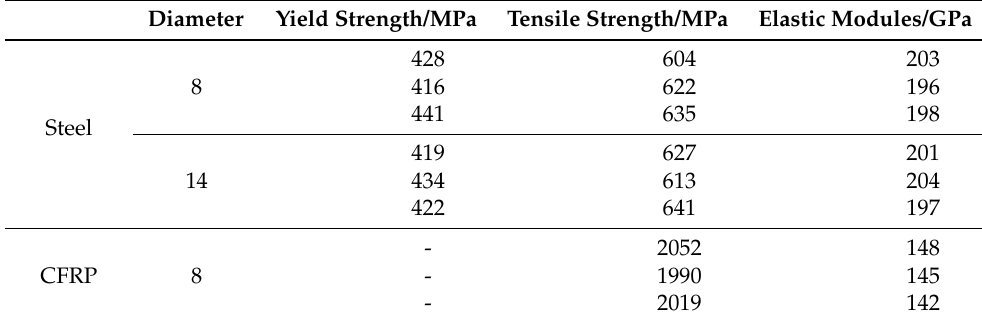
Table 1. Properties of steel bars and CFRP tendons.